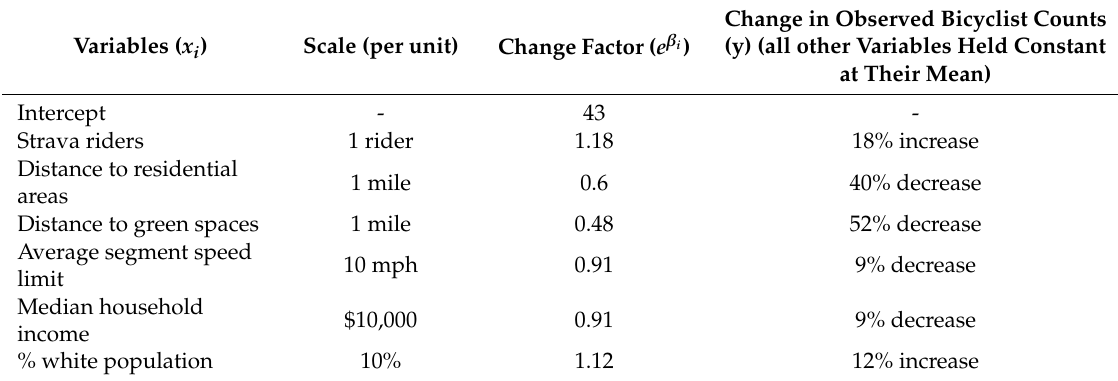
Table 4. Variation in predicted AADB counts for each variable, with all other attributes held constant, when the variable is changed by a factor, e β i